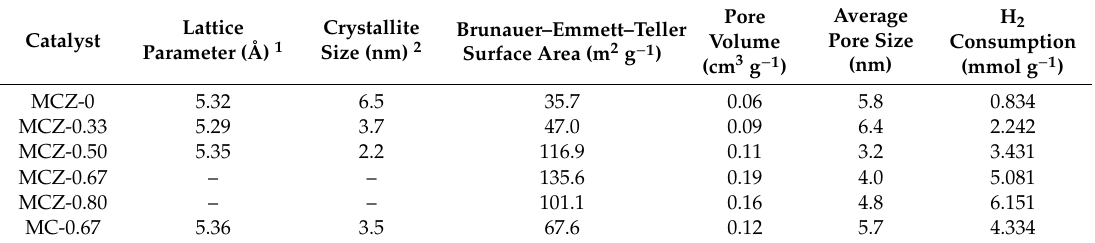
Figure 1. X-ray diffraction (XRD) patterns of MCZ-x (x = 0, 0.33, 0.50, 0.67, 0.80) and MC-0.67 Figure 1. X-ray di ff raction (XRD) patterns of MCZ-x (x = 0, 0.33, 0.50, 0.67, 0.80) and MC-0.67 catalysts. catalysts. Table 1. XRD, N 2 adsorption-desorption and H 2 -temperature programmed reduction (H 2 -TPR) characterization